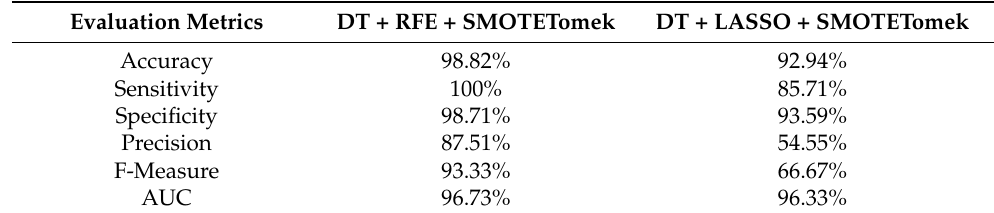
Figure 5. ( a ) ROC curve for DT + RFE; ( b ) ROC curve for DT + LASSO.